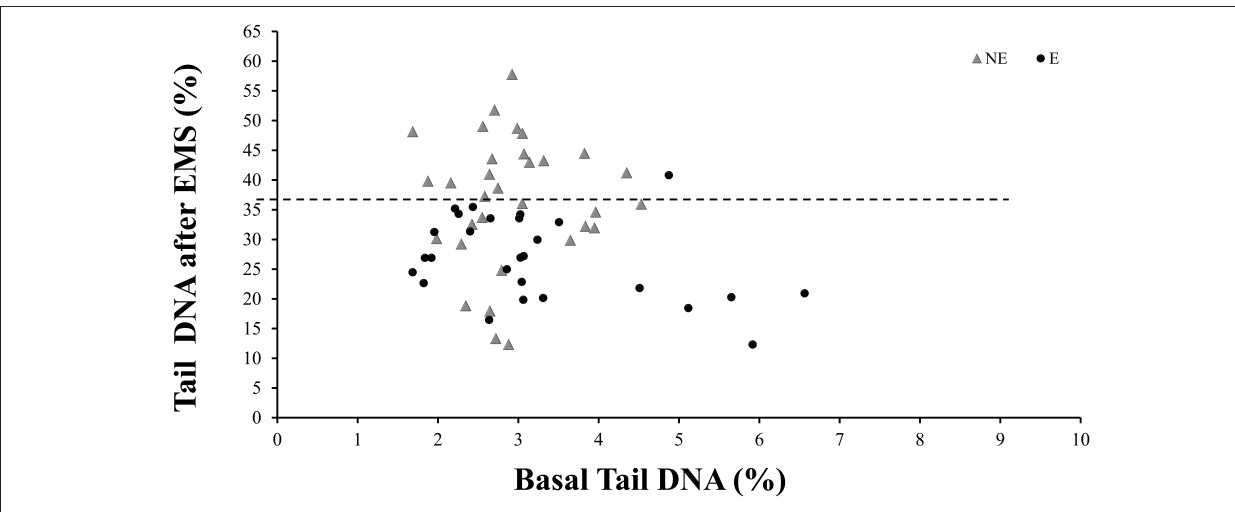
FIGURE 1 | Distribution of the tail DNA from non-exposed (NE) or Exposed (E) workers with and without the in vitro challenge with Ethyl Methanesulfonate (EMS). Each data point corresponds to one worker. Dashed line represents the mean value of DNA in tail for the NE, after challenge with EMS.